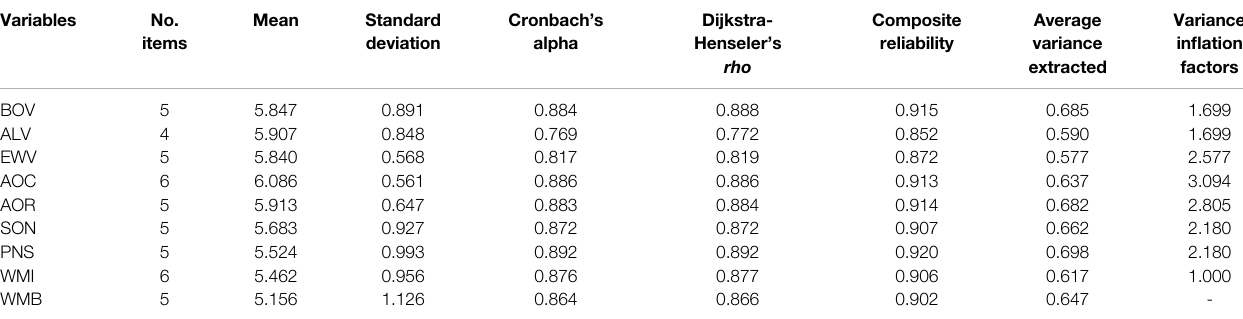
TABLE 2 | Reliability and validity.